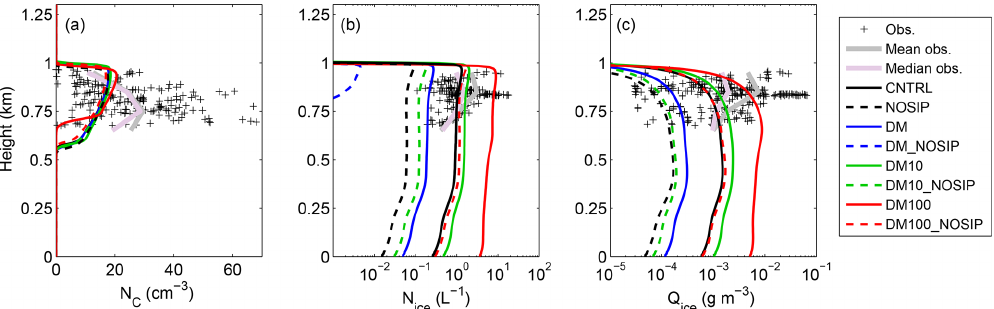
Figure 8. Same as Fig. 7 but for the LES sensitivity simulations with varying INP concentration. Black, blue, green and red solid (dashed) lines represent CNTRL (NOSIP), DM (DM_NOSIP), DM10 (DM_NOSIP) and DM100 (DM100_NOSIP) experiments,